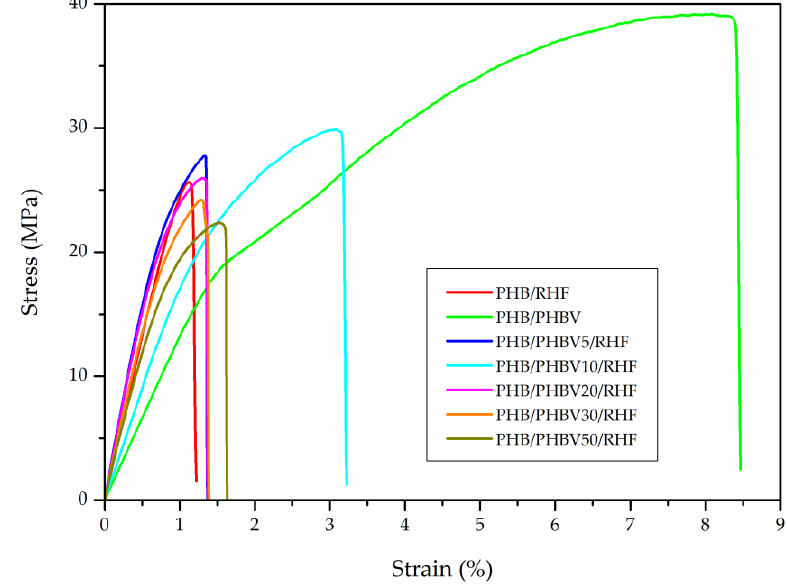
Figure 7. Tensile stress–strain curves of the thermo-compressed films made of poly(3-hydroxybutyrate) (PHB), poly(3-hydroxybutyrate- co -3-hydroxyvalerate) (PHBV), and rice husk flour (RHF). Table 5. Mechanical properties of the thermo-compressed films made of poly(3-hydroxybutyrate) (PHB), poly(3-hydroxybutyrate- co -3-hydroxyvalerate) (PHBV), and rice husk flour (RHF) in terms of: tensile modulus (E), tensile strength at yield (σ y ), elongation at break (ε b ), and toughness